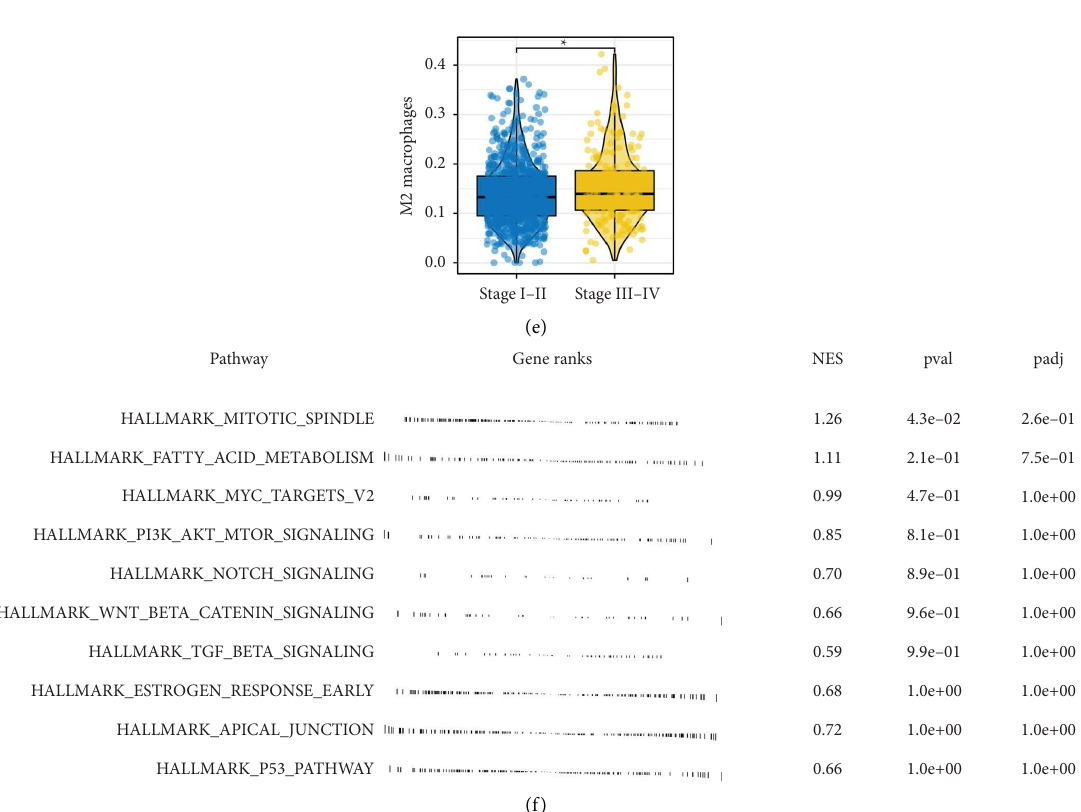
Figure 1: Exploration of M2 macrophages in lung cancer. (a) Quantifcation of M2 macrophages through the CIBERSORT algorithm in lung cancer; (b) KM survival curves of patients with high and low M2 macrophage infltration; (c)–(e) M2 macrophage infltration diference in patients with diferent clinical features, including T stage, N stage, and clinical stage, ns � P > 0 . 05, ∗ � P < 0 . 05, ∗∗∗ � P < 0 . 001; (f) biological enrichment of M2 macrophages based on the hallmark gene